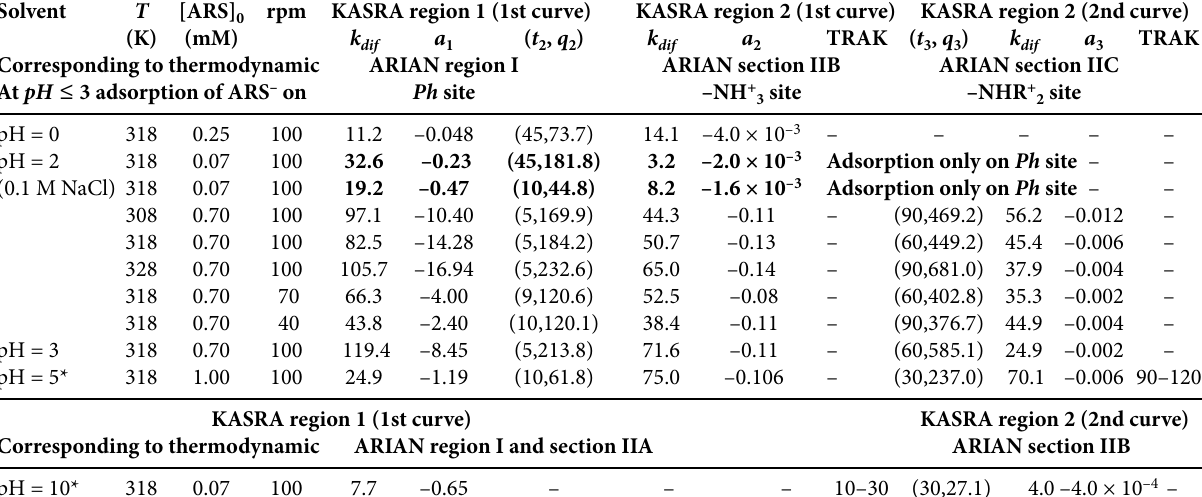
Table 5. Coefficients of the intraparticle diffusion equation for kinetics of ARS adsorption on GO/PAMAM at different temperatures and in various shaking rates and ARS initial concentrations. Solvent T